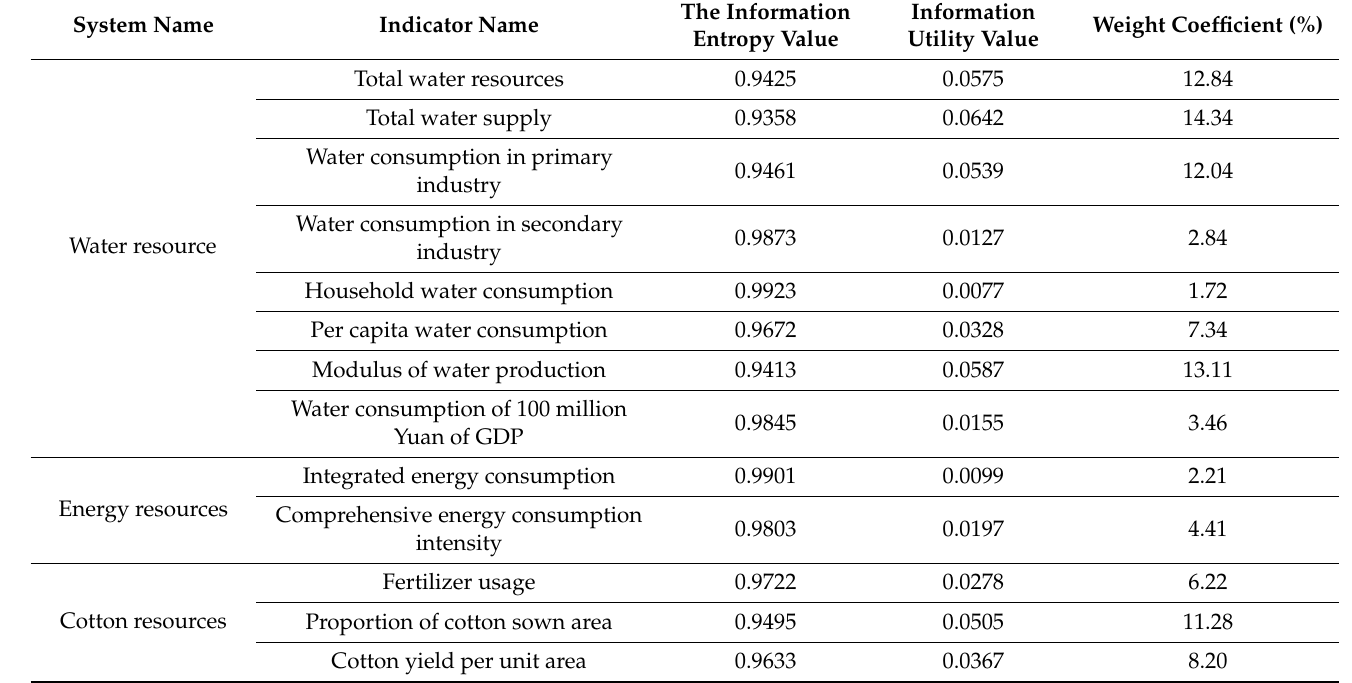
Table 2. Index weights of water–energy–cotton system in Tarim River